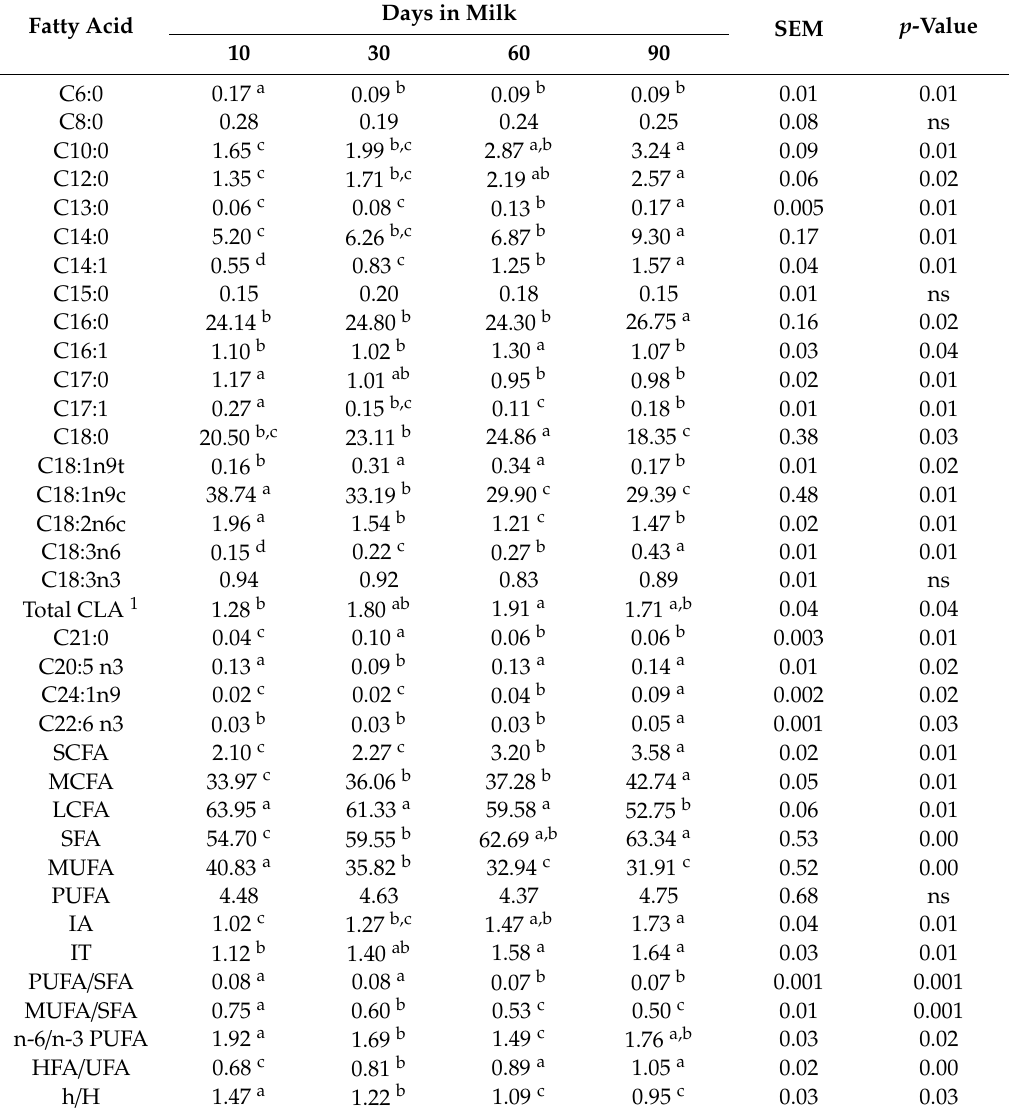
Table 4. Mean content (percentage of total FAME) of individual fatty acids (FAs) in the milk fat of Araucana creole ewes (n = 20) during 90 days of